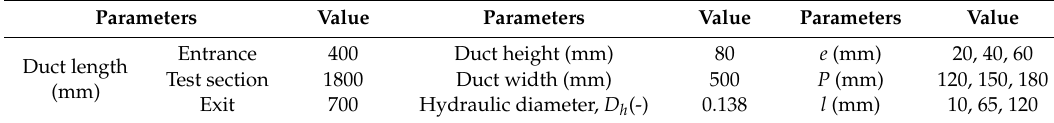
Figure 2. Schematics of the two ‐ dimensional computational domain. Table 1. Geometric parameters for solar air heater with a transverse triangular block at the bottom of air duct.